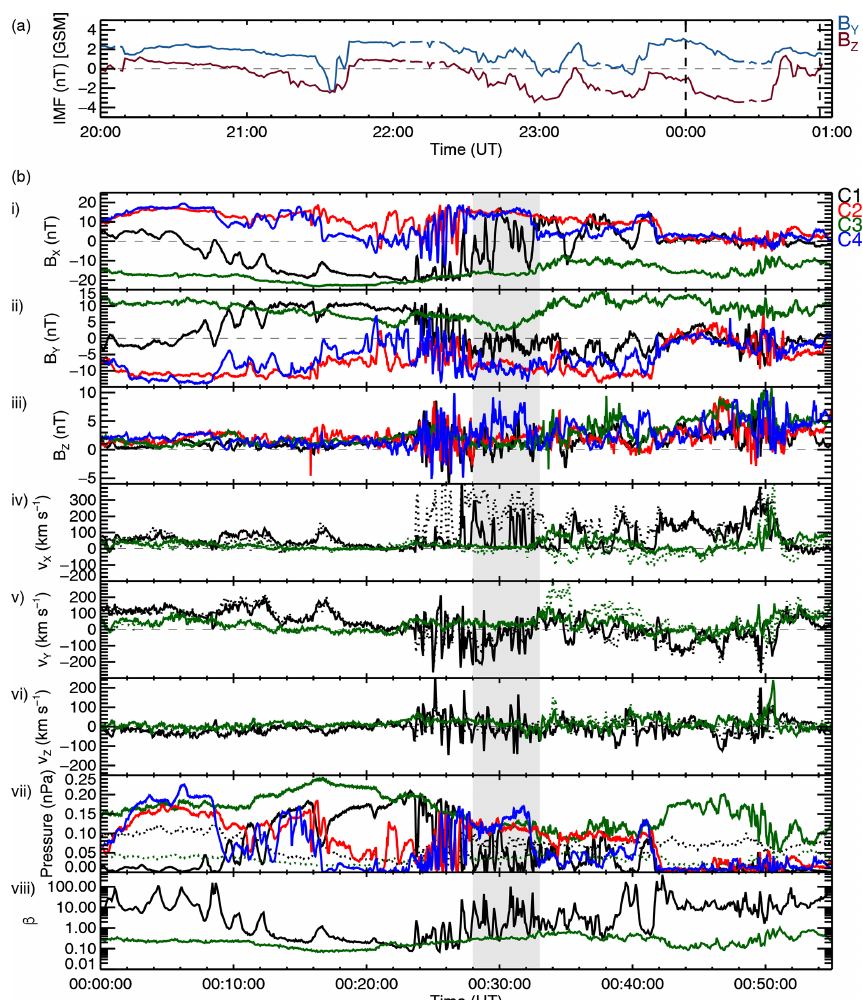
Figure 2. (a) A plot of the IMF time series data for the IMF B y (blue) and IMF B z (red) components, from 20:00UT on 11 October 2006 to 01:00UT on 12 October 2006. The vertical dashed lines indicate the start (00:00UT) and end (00:55UT) of the interval of Cluster data (below). (b) The in situ Cluster spacecraft measurements. Shown first is the local magnetic field data, (i) B x , (ii) B y and (iii) B z , followed by the bulk ion velocity data, (iv) v x , (v) v y and (vi) v z (dotted lines). The field-perpendicular component of the ion flow (indicative of the E × B convection) is shown in panels (iv) to (vi) by the solid lines. In panel (vii) the magnetic shown by the solid and dotted lines, respectively, and in panel (viii) the ion plasma beta from C1 and C3 is shown. All data are labelled according to the colour-coded key on the right-hand side. The time interval between the grey shaded region marks our specific interval of interest (discussed in the